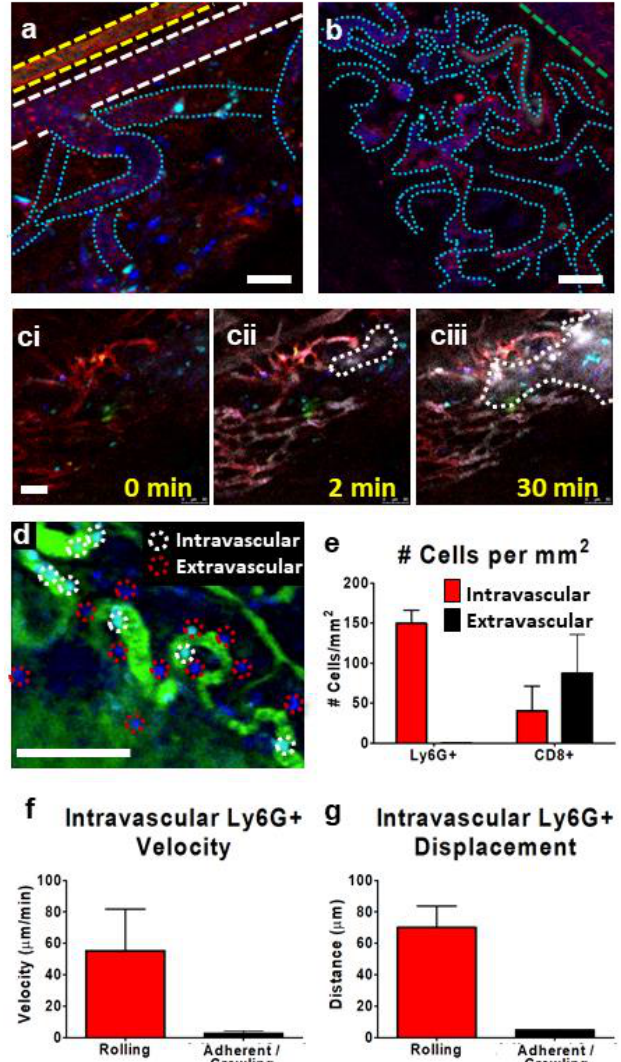
Figure 4. Characterization of subcutaneous CT-26 tumor microvasculature and leukocyte behavior. Representative IVM images ( a – c ) show the tumor microvasculature. The vasculature is highlighted by the presence of circulating platelets (red; PE-conjugated anti-CD49b), neutrophils (cyan; BV421-conjugated Ly6G), and CD8+ leukocytes (blue; eFluor 660-conjugated anti-CD8) ( a , b ). Using resonant scanning confocal microscopy, arterioles (yellow outline, a ), veins (green outline, b ) were seen as parallel unbranching structures. Venules were seen as narrower than veins and appeared as branching vessels (white outline, a ), whereas capillaries/tumor microvasculature appeared as very narrow, convoluted vessels (cyan outline, a , b ). Intravenous administration of fluorescent nanoparticles (Q-tracker; grey) identified areas of vascular leakage and accumulation of dye in the tissue interstitium (outlined in dotted white line) ( ci – ciii ). The introduction of FITC-conjugated albumin (green) allowed for an easy determination of intravascular (red circles) or extravascular (white circles) leukocytes ( d ). Quantification of intravascular (red) or extravascular (black) neutrophils (Ly6G+) and cytotoxic T cells (CD8+) (cells present for ≥3 min) within the tumor microvasculature ( e ). Velocity ( f ) and displacement ( g ) of rolling and adherent and crawling neutrophils as measured over a 10 min imaging period in a subcutaneous CT-26 tumor; n = 3 animals. Data displayed as the mean ± SEM. Total cell counts normalized for the area of each region of interest within each image (i.e., vessel vs. extravascular tissue). The white scale bar represents 50 µ m. Images in ( a – d ) were captured using resonant scanning confocal